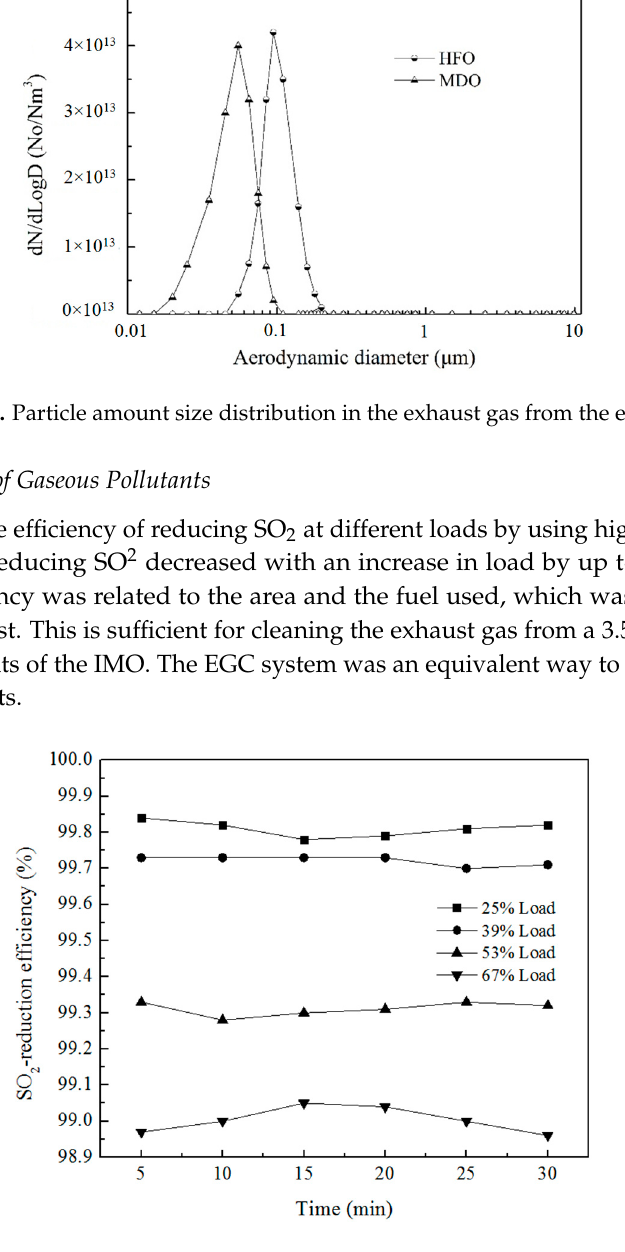
Figure 6. Efficiency in reducing SO 2 with different engine loads.